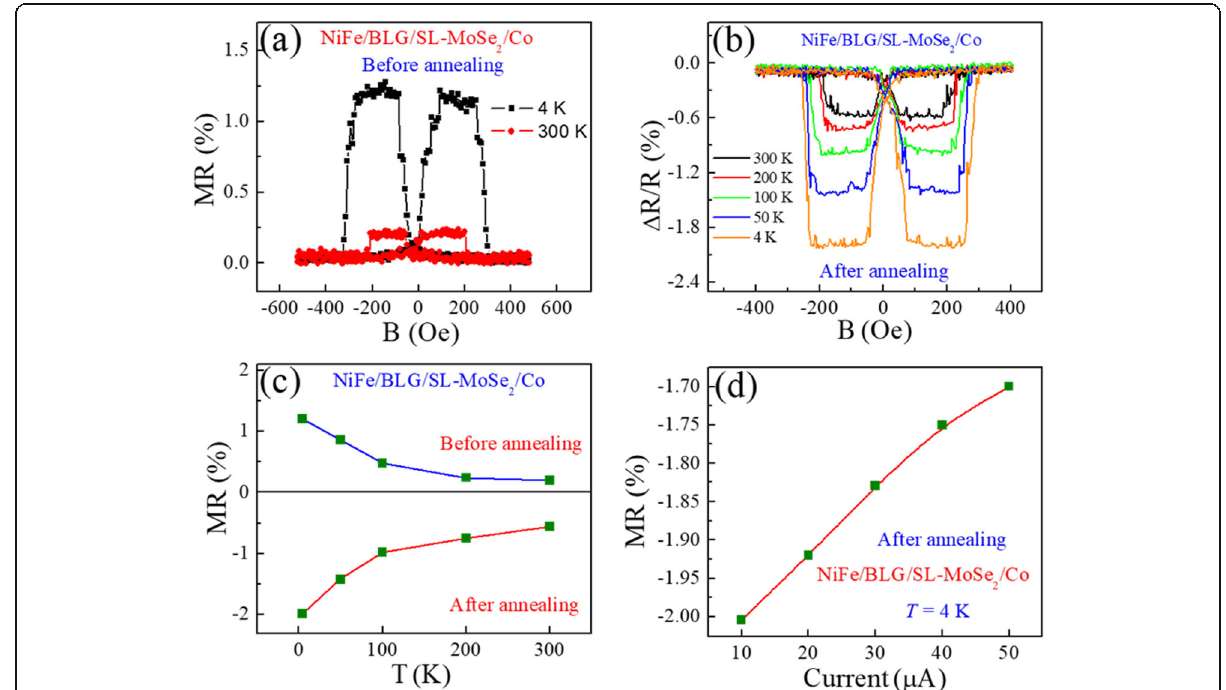
Fig. 4 a Before annealing, the MR traces as a function of the magnetic field at T = 300, 4 K and I = 10 μ A. b After annealing, the MR traces vs magnetic field, B, at different temperatures. c Before and after annealing, the MR values at T = 300, 200, 100, 50, and 4 K. d The MR magnitudes of NiFe/BLG/SL-MoSe 2 /Co at different current